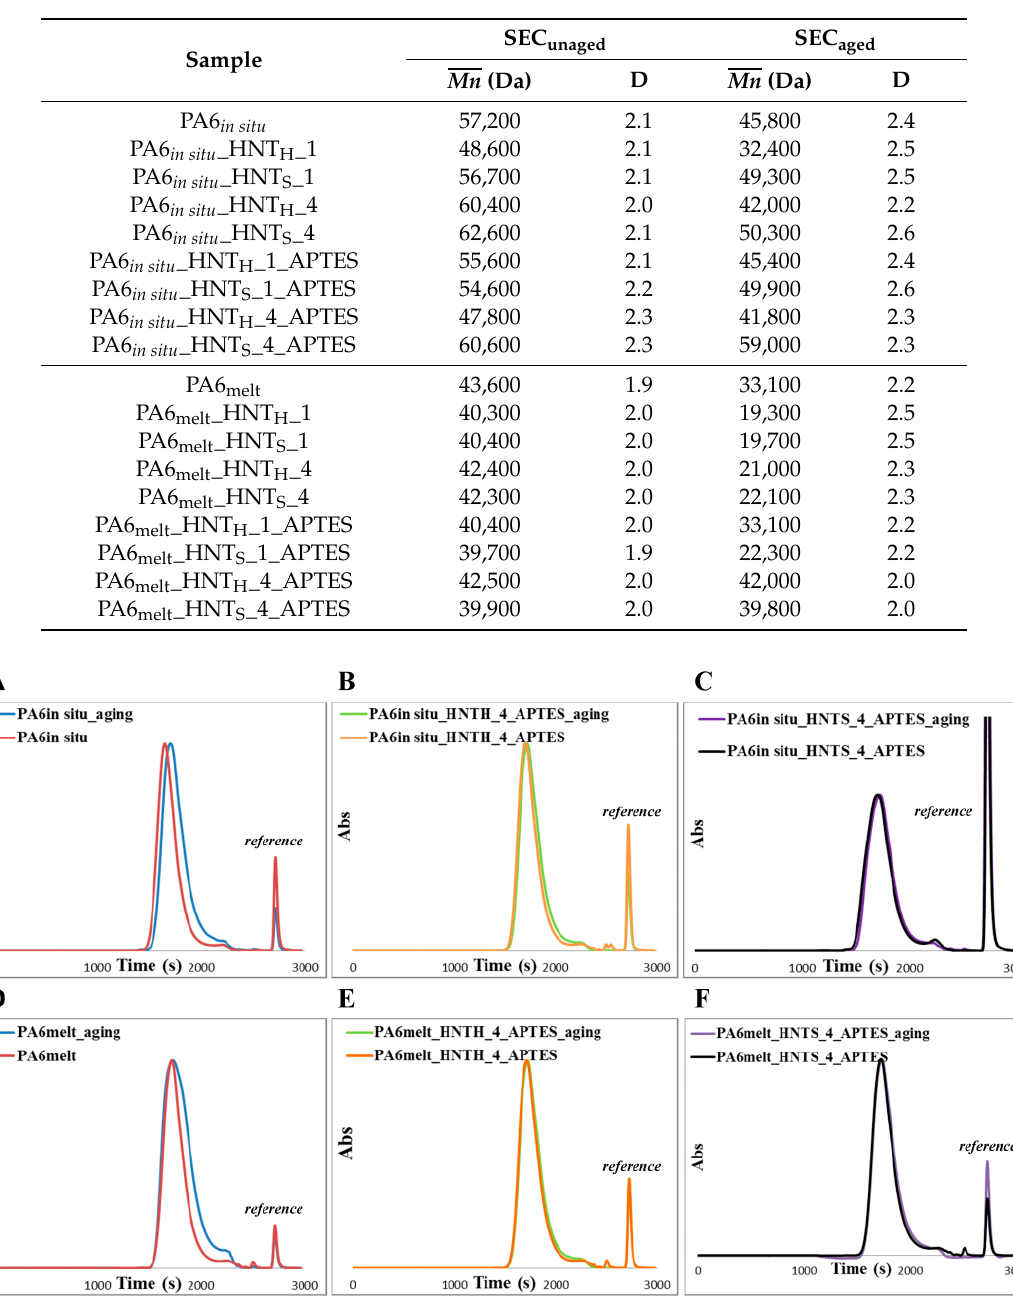
Table 4. Number average molecular weight ( Mn ) and molecular weight distribution (D) data of PA6_HNT nanocomposites collected before and after the hydrothermal ageing test.